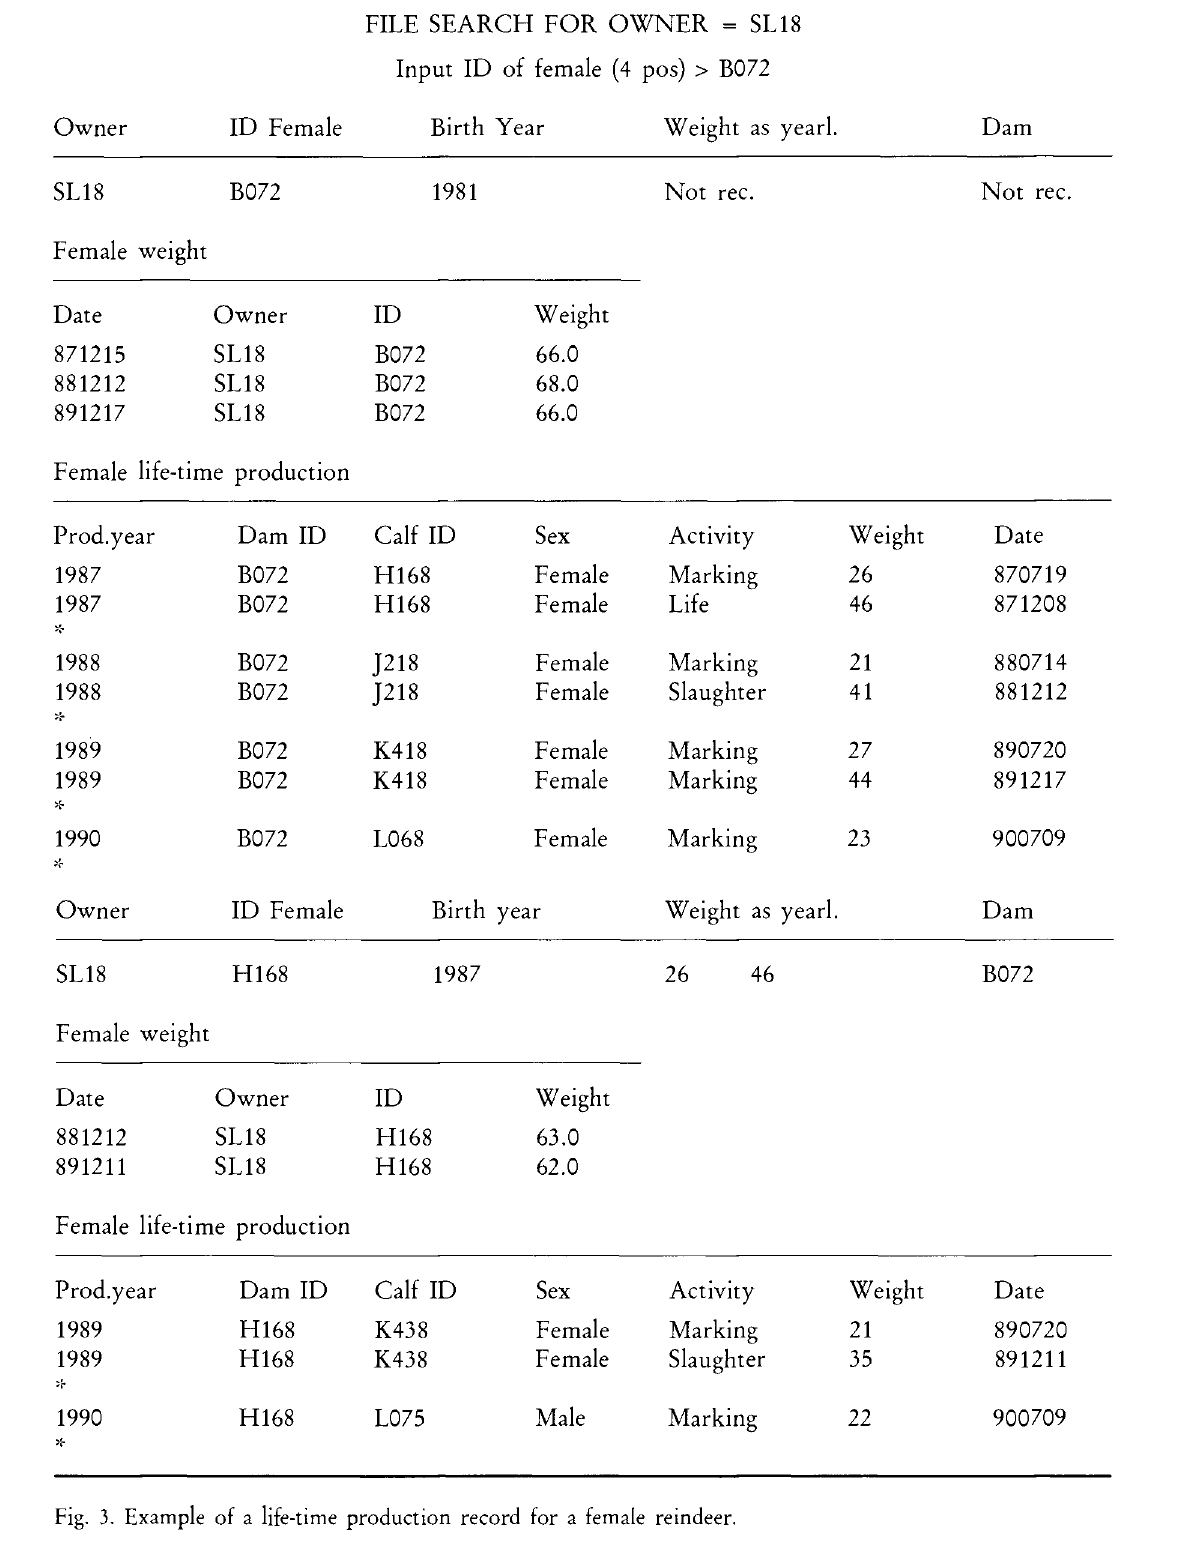
Fig. 3. Example of a life-time production record for a female